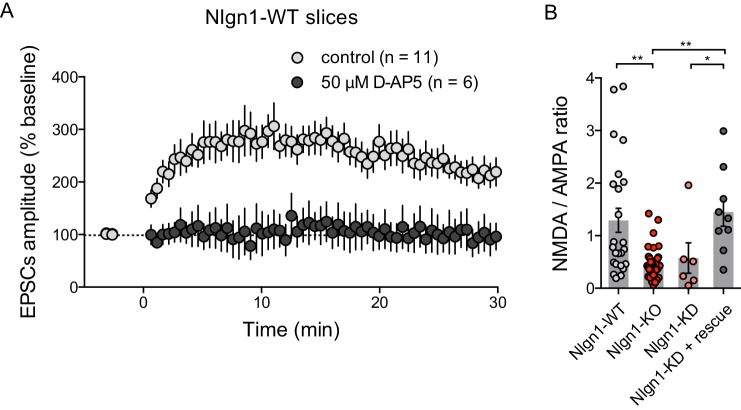
LTP dependence on NMDARs and effect of Nlgn1 expression level on the NMDA/AMPA ratio.(A) Evoked AMPAR-mediated EPSCs upon induction of LTP at time zero, normalized to baseline, in control ACSF or in the presence of 50 µM D-AP5. Note the abolishment of LTP in the AP5 condition. (B) Quantification of the ratio between NMDAR-mediated and AMPAR-mediated EPSCs calculated in the same CA1 neurons, for different conditions: control unelectroporated neurons from either wild type (Nlgn1-WT, light grey) or Nlgn1-KO (red) slices, neurons from WT slices electroporated with shRNA to Nlgn1 (Nlgn1-KD, pink), and neurons co-electroporated with shRNA to Nlgn1 and AP-tagged Nlgn1 rescue construct (dark grey).